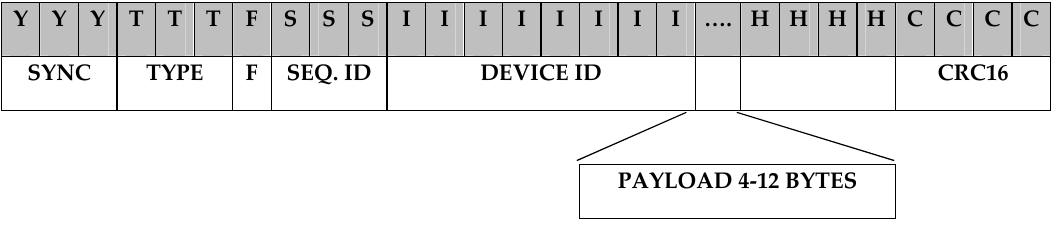
Figure 13. Upload message structure in SIGFOX.